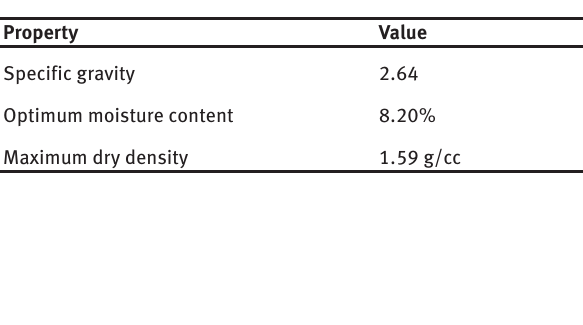
Table 5: Geotechnical properties of